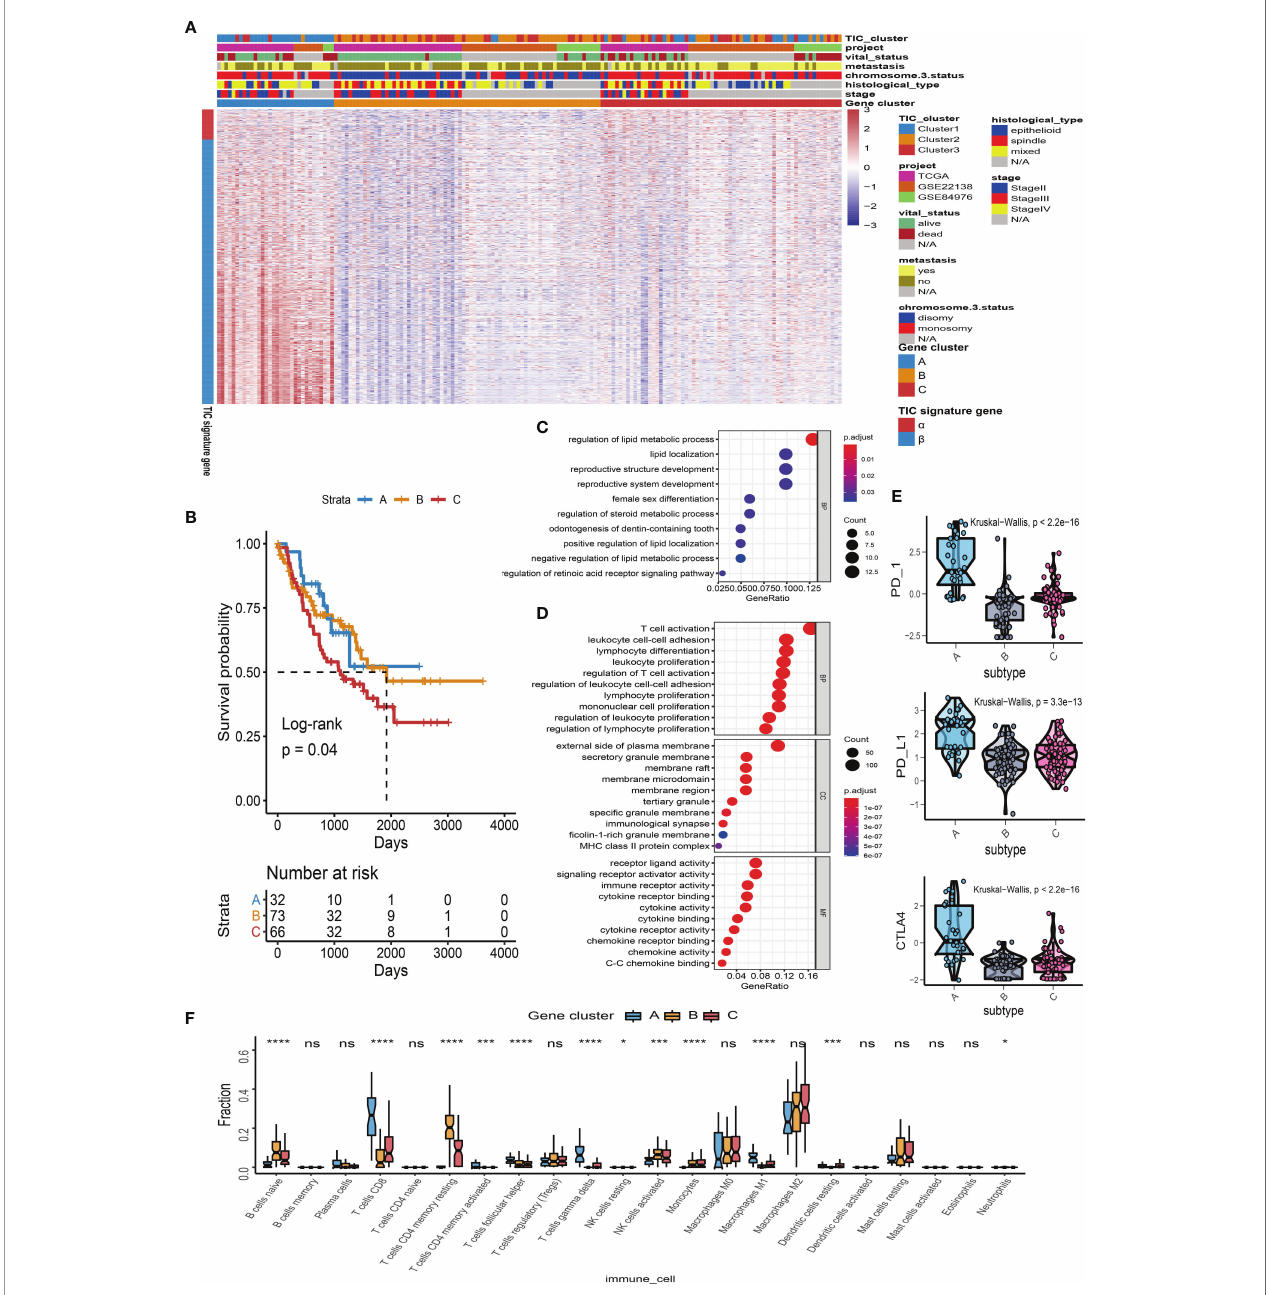
FIGURE 3 | Immune gene-related cluster. (A) UM patients were classi fi ed into three subgroups (Clusters A to C) by using unsupervised clustering of DEGs among three TIC subtypes. Clustering analysis of prognostic ferroptosis-related genes (FRGs) in melanoma. (B) Kaplan – Meier plot for the three subgroups of patients. (C) Gene Ontology (GO) enrichment of feature a gene set. (D) GO enrichment of feature b gene set. (E) Box plots of immune checkpoint genes (PD-1, PD-L1, and CTLA-4) in three gene-related clusters. (F) Box plots of in fi ltrated immune cells in three gene-related clusters. * p < 0.05; *** p < 0.001; and **** p < 0.0001. NS means “ none signi fi cance ”